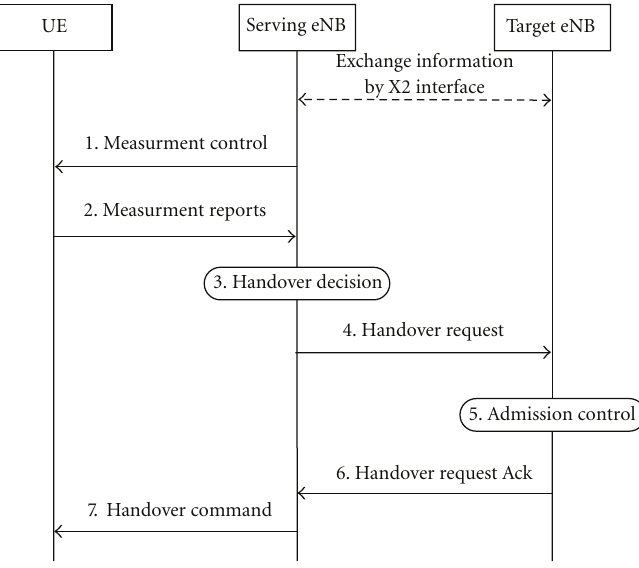
Figure 2: The handover preparation procedure.